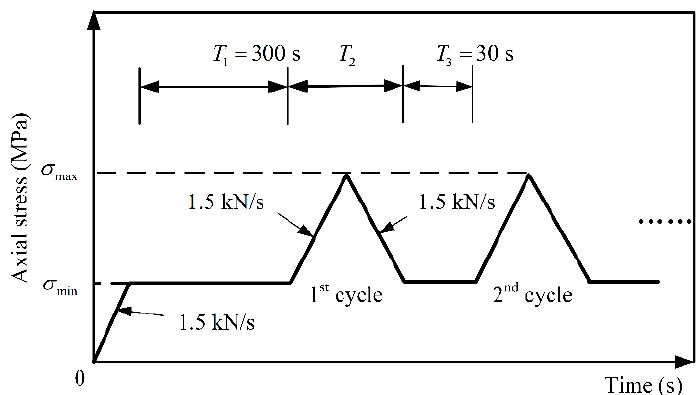
Figure 3. A microprocessor control tester.